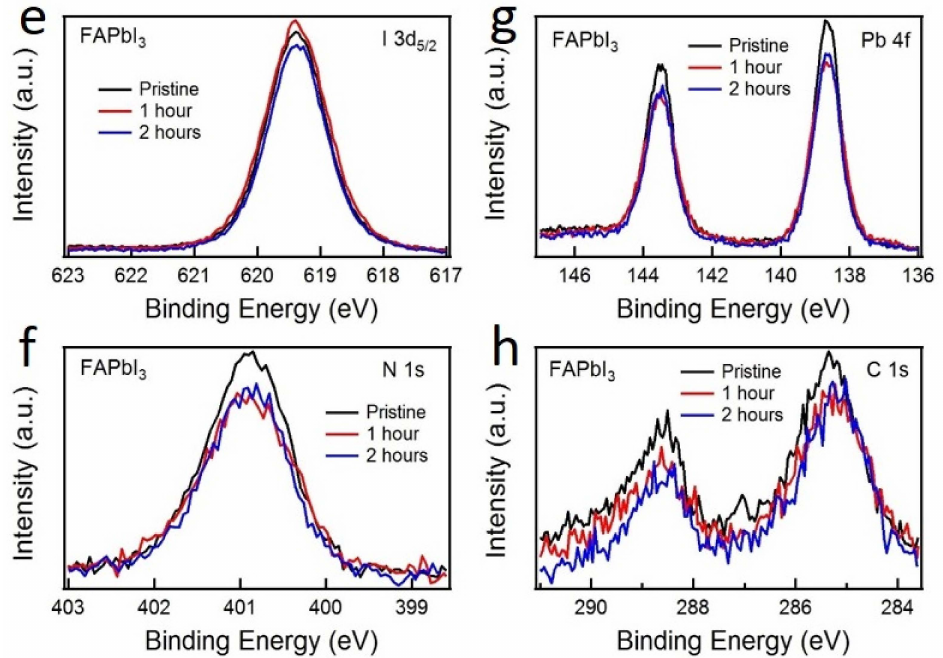
Figure 1. High-resolution spectra of I 3 d 5 / 2 , N 1 s , Pb 4 f and C 1 s obtained from MAPbI 3 ( a – d ) and FAPbI 3 ( e – h ) samples before and after water vapor exposure to di ff erent periods, respectively.